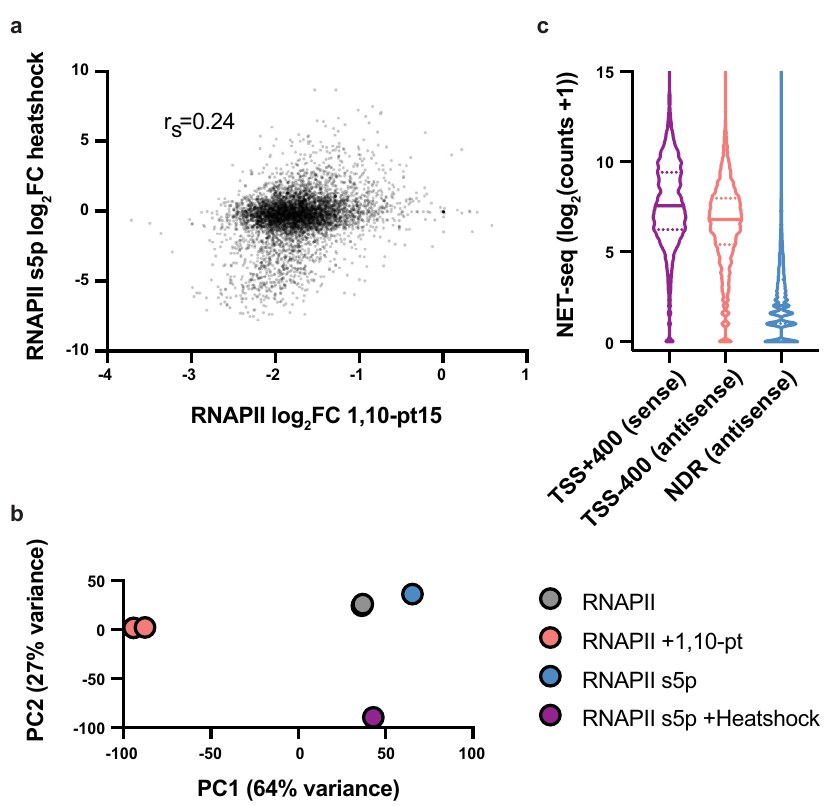
Fig. 2 Transcription inhibition with 1,10-phenanthroline (1,10-pt) does not mirror the effect of heat shock on RNAPII occupancy at most genes. a Scatter plot comparing the log 2 fold change (FC) in RNAPII occupancy following treatment with 1,10-pt with RNAPII serine 5 phosphorylation (s5p) following heat shock in gene 5 ′ regions (TSS to + 400 bp) for all (5542) genes. b PCA plot showing the fi rst two principal components calculated across TSS to + 400 bp for all (5542) genes. c NET-seq 3 ′ read counts from TSS to + 400 nt (sense), TSS to − 400 nt (antisense), or in NDRs (antisense) depicted by violin plots for all (5542)